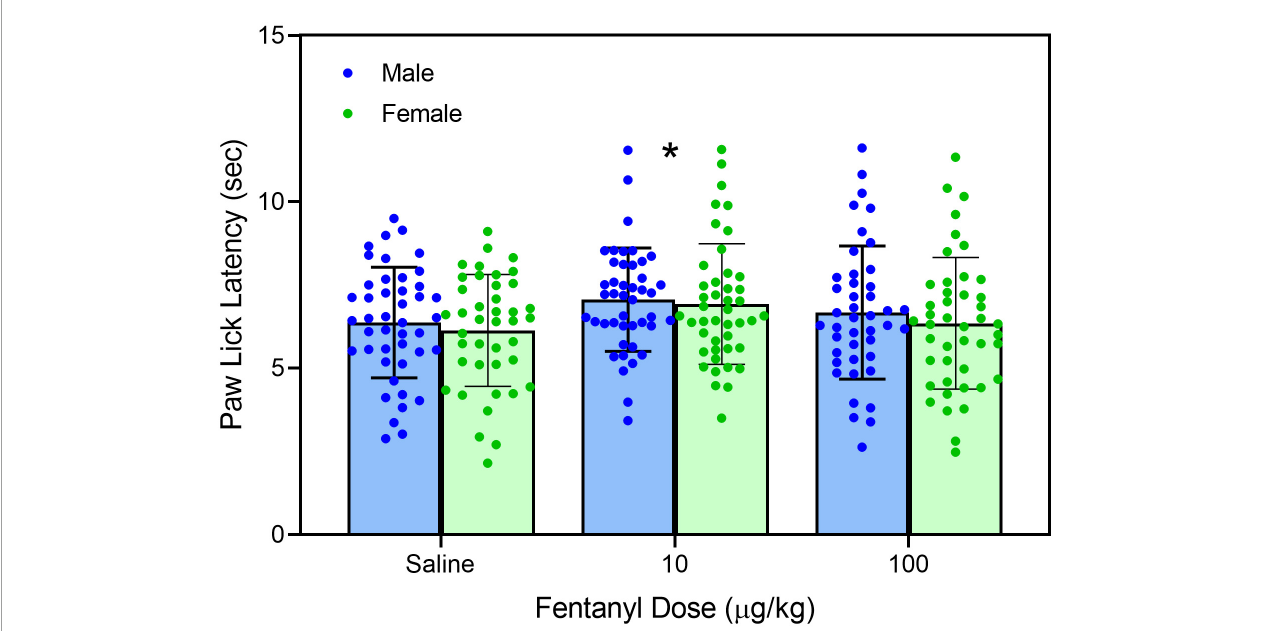
FIGURE2 Mean (+SE) baseline paw-lick latencies of PD 60 male and female rats ( n = 8–9/sex). Rats were pre-treated with fentanyl (10 or 100 µ g/kg) or saline from PD 4 to PD 9. *Significantly different from rats in the saline-pre-treatment group.